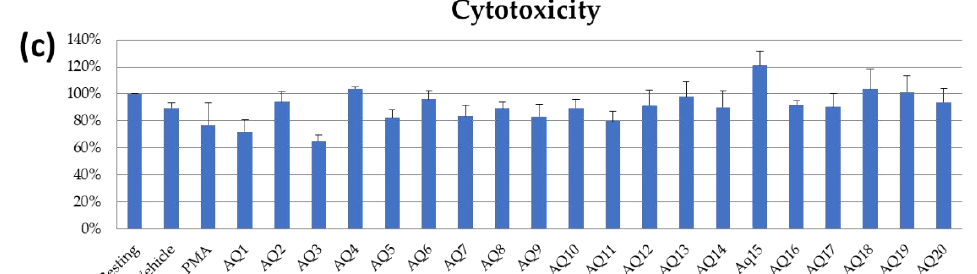
Figure 4. Effects of the isolated compounds AQ — AQ20 on MMP-2 and MMP-9 activity and cytotoxicity. ( a ) Results of gelatin zymography. ( b ) Activity of the compounds on MMPs expression. ( c ) Cell viability test. Data represent the mean ± SD ( n = 3). PMA (5 μΜ ); AQ1 — AQ20 (50 μΜ ); * p < 0.05, ** p < 0.001.